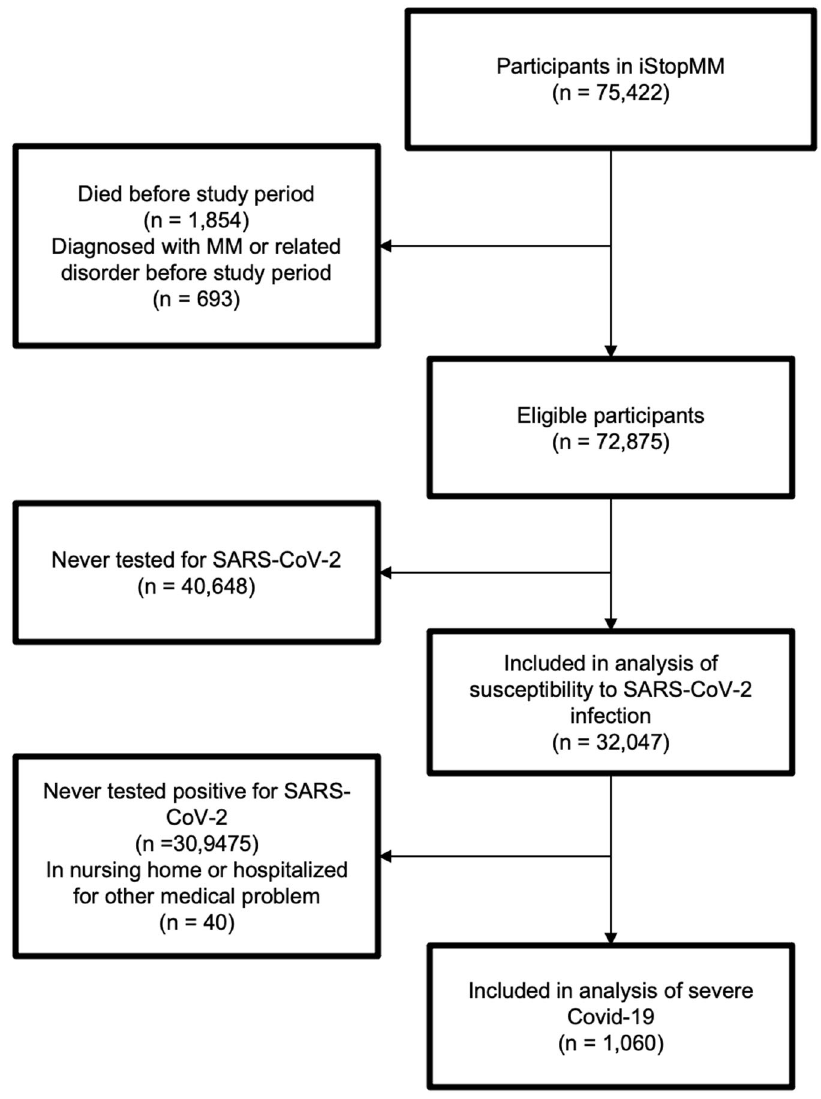
Fig. 1 Participant selection. Flowchart demonstrating the inclusion and exclusion of participants.